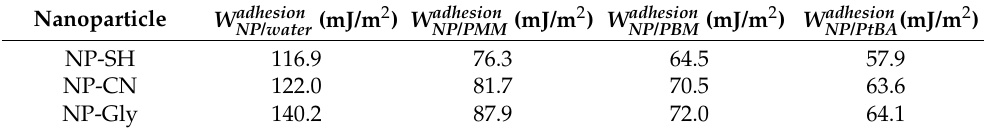
Table 3. The calculated values of the work of adhesion based on Equation (3), where the surface energy values for the NPs were taken from Table 2 and for the polymers from reference